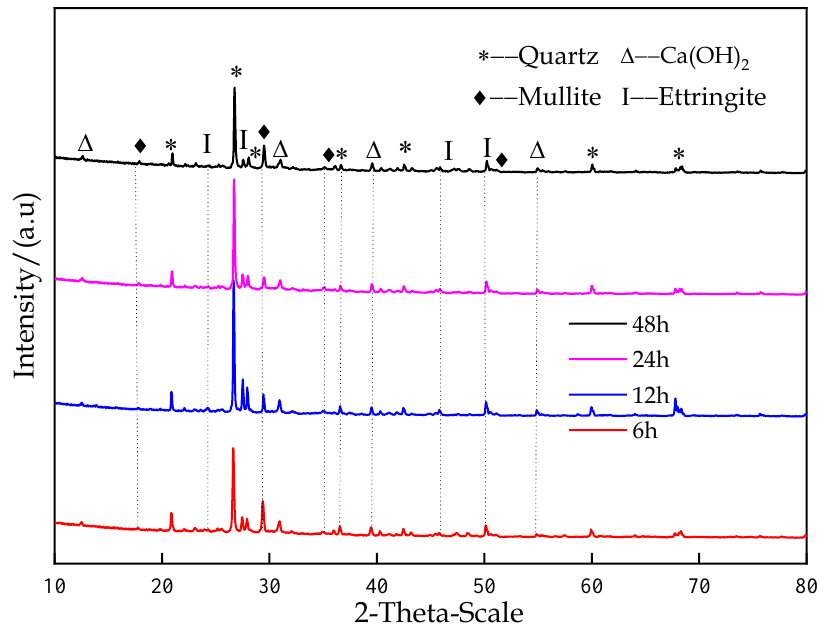
Figure 12. Formation of hydration products.